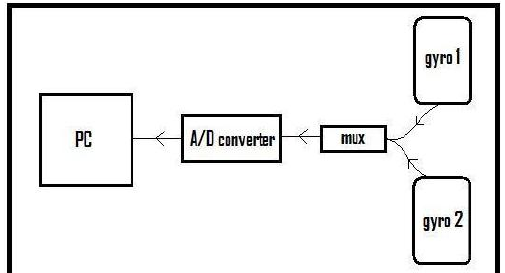
Figure 4. Block diagram of the experimental